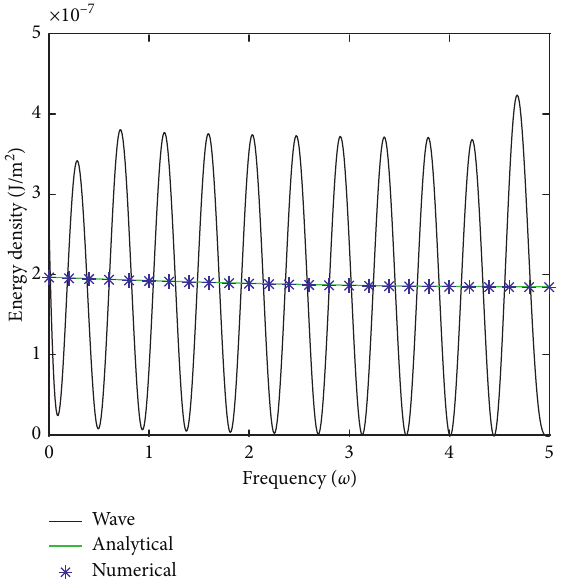
Figure 11: Energy densities of the beam in space.